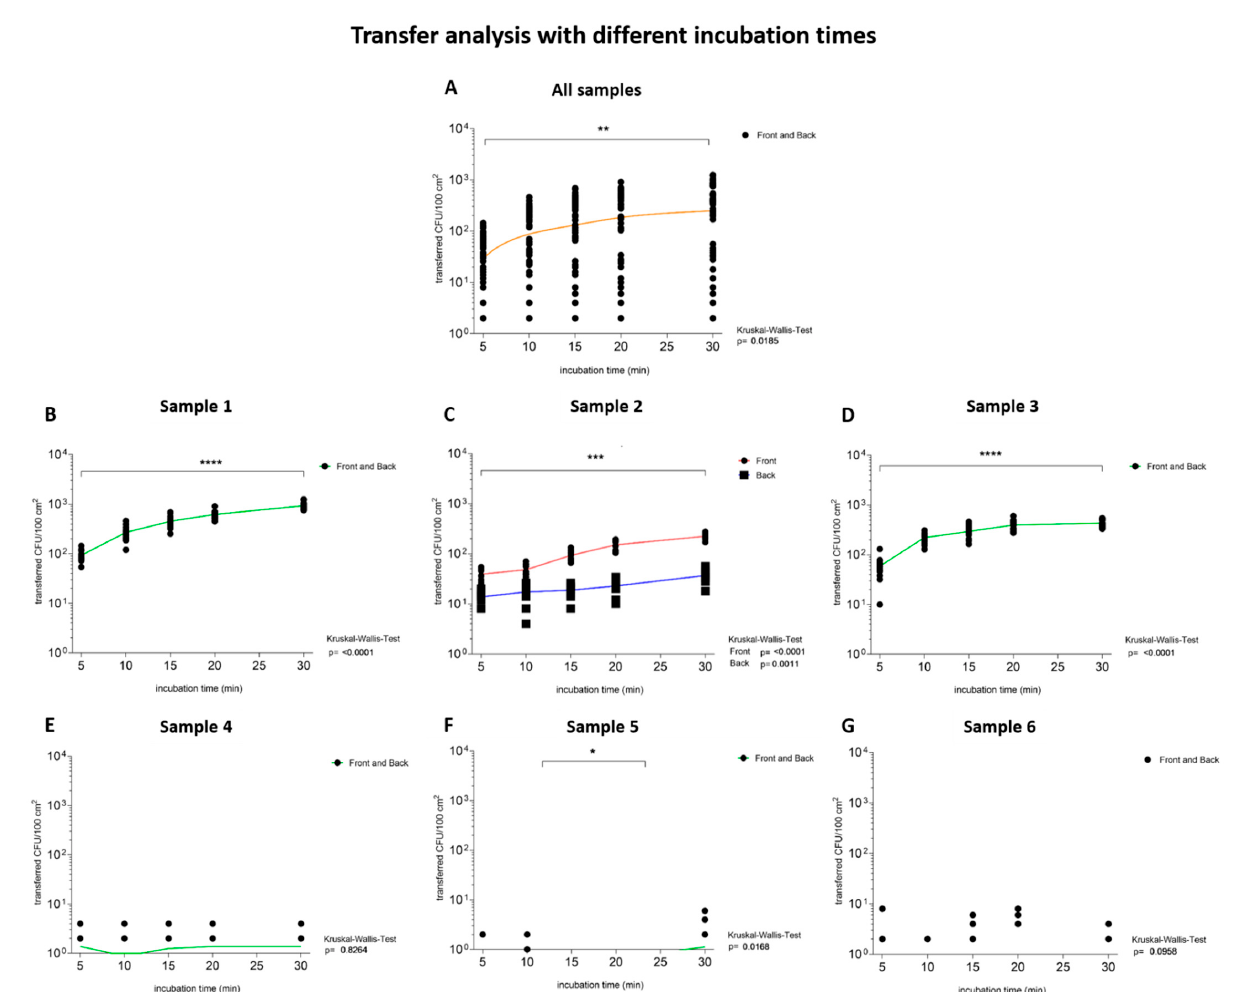
Figure 5. The transfer of microorganisms is time-dependent for samples with a high total CFU/100 cm 2 . The increasing incubation time in minutes is depicted. The nodes (black) depict transferred CFU/100 cm 2 from the outer layers of the packaging material to the TSA plates after the samples were loaded with 250 g for 5 min, 10 min, 15 min, 20 min and 30 min. The locally estimated scatterplot smoothing (LOWESS: orange) and the Kruskal–Wallis test were calculated to analyze the dependence on incubation time of the transfer. Lines were drawn through the mean values of all measured data points to illustrate the dependence of the transfer on the tested parameter. Green lines illustrate data from both outer layers, while red lines represent data from the front and blue lines from the back. A p -value of below 0.05 was defined as statistically significant. ( A ) The graph indicates a time dependent transfer of microorganisms over all tested samples, since the transferred CFU/100 cm 2 increases significantly ( p = 0.02) with increasing incubation time. ( B – D ) Packaging materials with a high total CFU/100 cm 2 showed a time-dependent transfer ( p < 0.01). ( E , G ) The eval- uations revealed no significant microbial transfer ( p > 0.05) of samples with a low total CFU/100 cm 2 . ( F ) Sample 5, with a low total CFU/100 cm 2 , showed a time-dependent transfer ( p = 0.02). * Indicates statistical significance with a p -value below 0.05, ** indicates statistical significance with a p -value below 0.01, *** indicates statistical significance with a p -value below 0.001 and **** indicates statistical significance with a p -value below